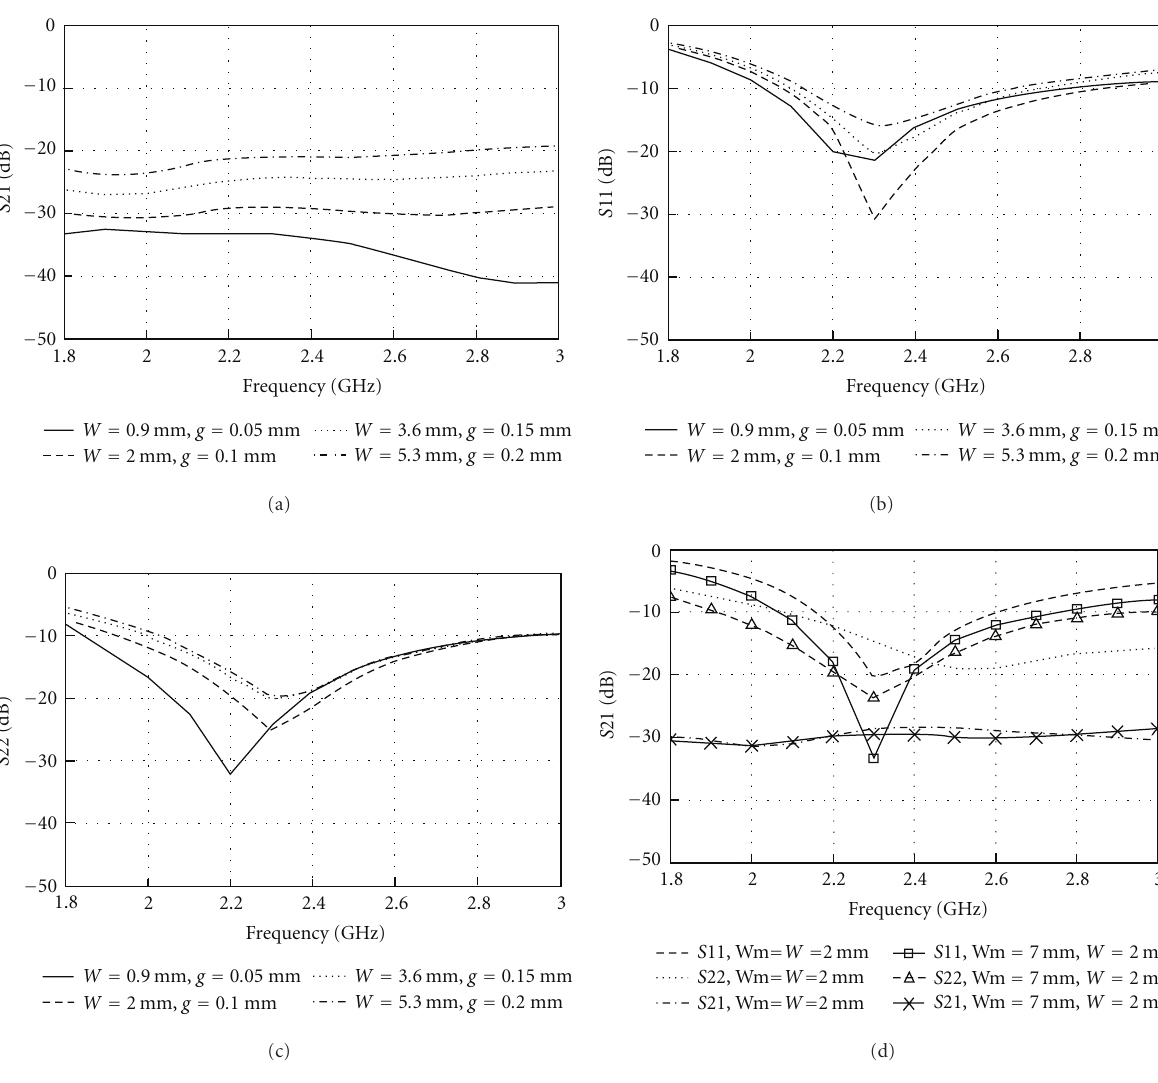
Figure 13: Parametric study of the